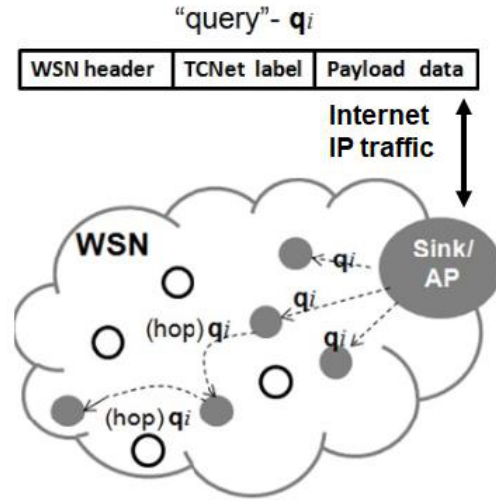
Figure 1. Scenario of a sink node querying a set of sensor nodes in a WSN and the frame structure used by the TCNet